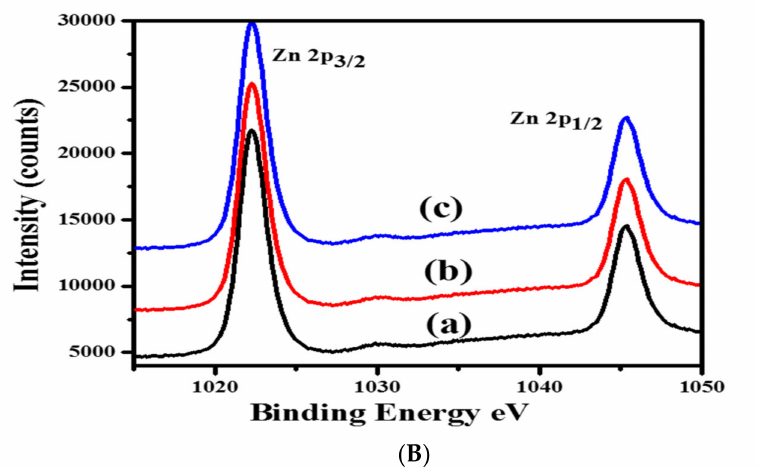
Figure 7. ( A ) XPS Cu2p spectra with peak fitted graph of ( a ) 1Cu/ZIF-8N2 ( b ) 2Cu/ZIF-8N2 ( c ) 3Cu/ZIF-8N2 ( B ) Zn2p spectra of ( a ) 1Cu/ZIF-8N2 ( b ) 2Cu/ZIF-8N2 ( c )